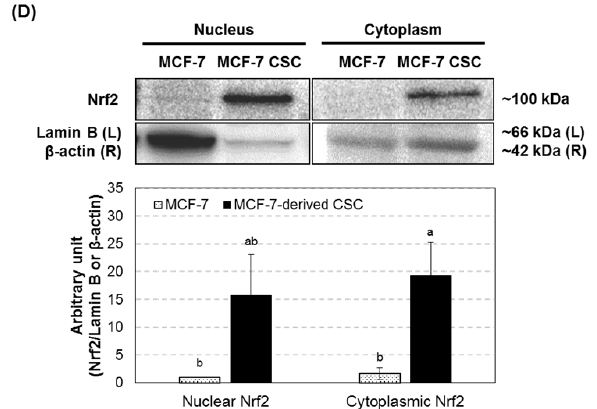
Figure 1. MCF-7-derived CSCs were more resistant to paclitaxel with higher expression of Nrf2 than MCF-7 cells. ( A , B ) Representative phase contrast images of MCF-7 cells ( A ) and MCF-7-derived CSCs ( B ) in culture. Scale bars in the images indicate 100 µ m. ( C ) Cell viability in the presence of various concentrations of Taxol (1, 0.1, 1, 10, 25, and 50 nM). ( D ) Nrf2 protein expression levels in nuclear and cytoplasmic fractions from MCF-7 cell and MCF-7-derived CSC lysates. Representative immunoblot image (upper) and quantitative data (lower). N (independent experimental sessions) = 4; error bars, mean ± SEM. Values not sharing common letter on bar indicate statistically significant difference from each other ( p < 0.05).